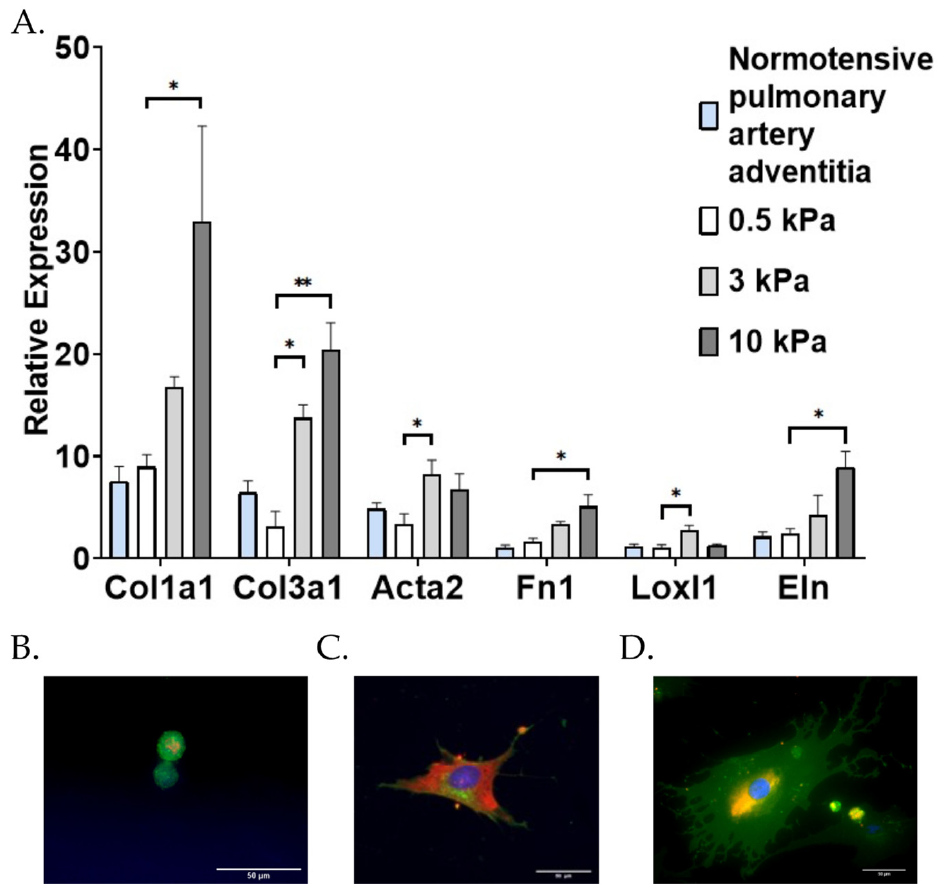
Figure 3. Effect of substrate stiffness on pulmonary arterial adventitial fibroblast (PAAF) differentiation. ( A ) Mean ± standard errors of the mean relative to housekeeping gene 18S ribosomal RNA of PAAFs cultured at different stiffness ( n = 9) compared with gene expression of sections in a normotensive pulmonary artery adventitia ( n = 6). Effect of stiffness (* p < 0.05 and ** p < 0.0001) by one-way analysis of variance (ANOVA) compared with control 0.5 kPa with a post-hoc Dunnett’s test. ( B – D ) PAAFs plated on ( B ) 0.5 kPa (40 × ), ( C ) 3 kPa (20 × ) polyacrylamide gel and ( D ) plastic (40 × ), scale bar 50 µ m. Cells were stained with DAPI, which stains the nucleus (blue), wheat germ agglutinin stains the membrane (green), and α -SMA filaments